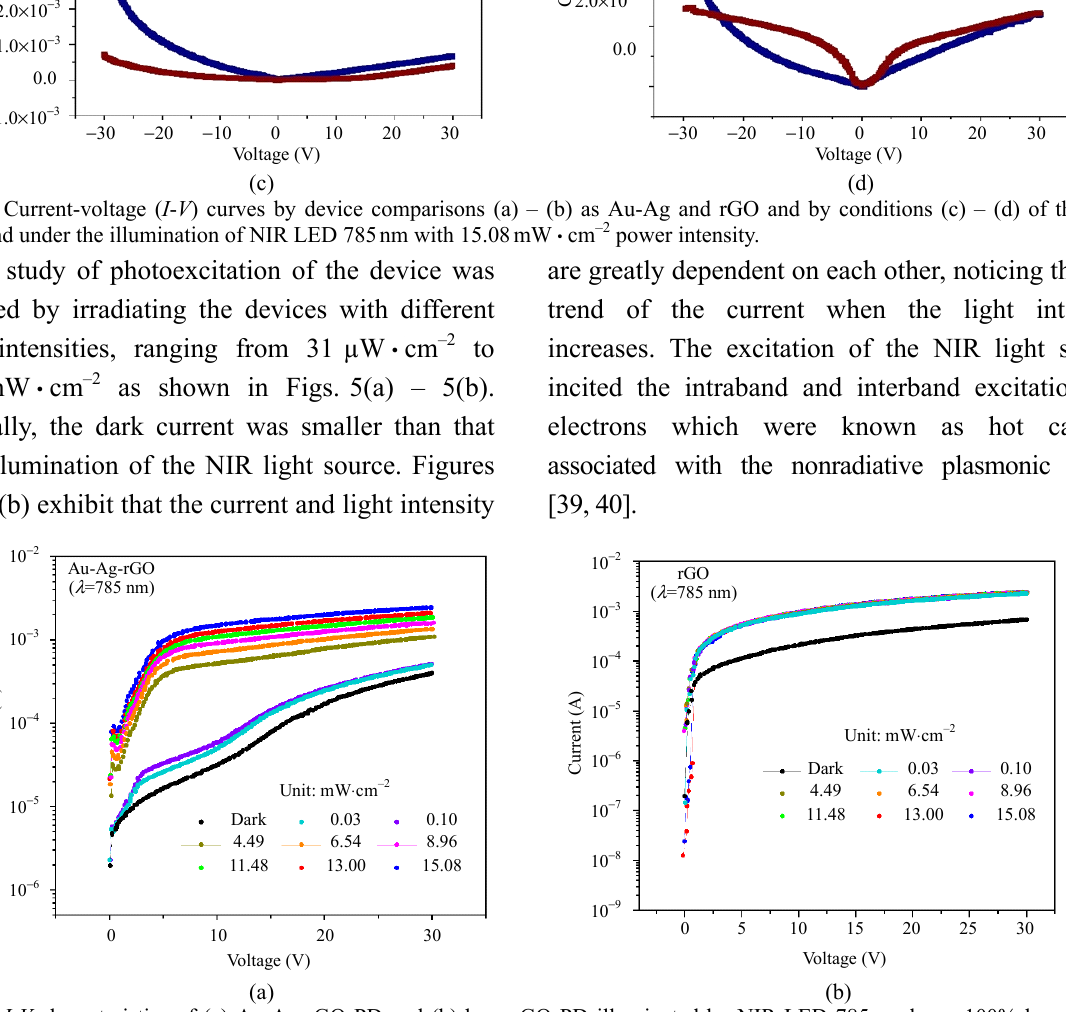
Fig. 5 I - V characteristics of (a) Au-Ag-rGO PD and (b) bare rGO PD illuminated by NIR LED 785 nm laser. 100% laser power intensity was 15.08 mW  cm − 2